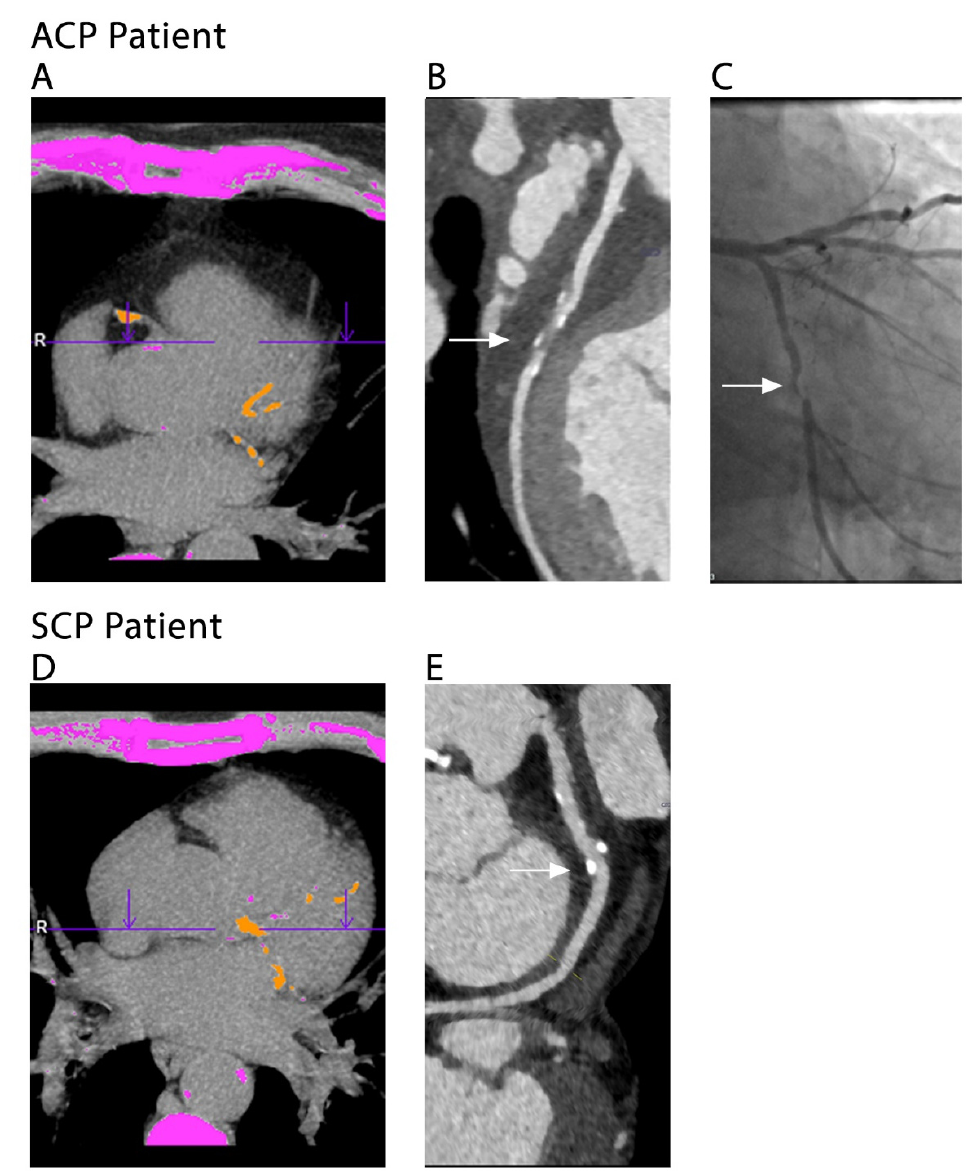
Figure 4. CT scan examples of an ACP and a SCP patient. ( A – C ) 67-year-old male ACP patient with a history of hypertension, hyperlipidemia and smoking. ( A ) CACS scan of 461 au. ( B ) CCTA shows a severe calcified lesion in the circumflex artery (CX) (arrow). ( C ) Subsequent ICA demonstrates the same severe lesion in the CX (arrow). ( D , E ) 65-year-old male SCP patient with a history of hyperlipidemia and smoking. ( D ) CACS scan of 418 au. ( E ) CCTA shows a non-obstructive calcified lesion in the CX. ICA was not performed since it was not indicated. ACP: acute chest pain, au: Agatston Units, CACS: coronary artery calcium score, CCTA: coronary CT angiography, CX: circumflex artery, ICA: invasive coronary angiography, SCP: stable chest pain.